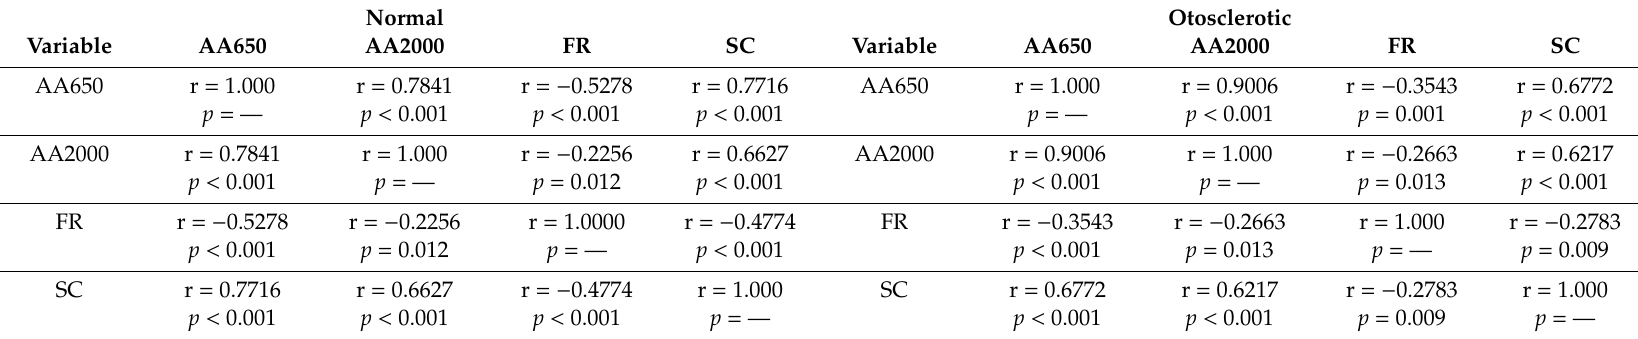
Table 5. Cross-correlation coe ffi cients ( r ) and related p -values between absorbance-related measures in the Normal and Otosclerotic